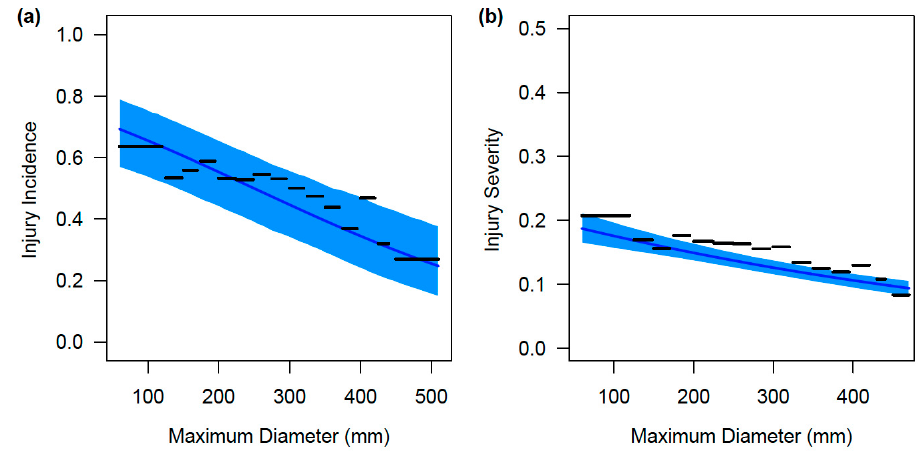
Figure 5. Relationship (with 95% confidence intervals (CI) generated by parametric bootstrap) between ( a ) CoTS maximum diameter and the probability of the individual to have experienced arm damage (injury incidence; binary data), as measured by the median observer on an average reef; ( b ) CoTS maximum diameter and the severity of an individual's injury on an average Reef (note y-axis has been truncated to aid visualization of the relationship). Black horizontal lines represent the mean probability of individuals in 25mm size classes (<125, 125–150, 150-175, …, >450 mm) superimposed over the relationship.